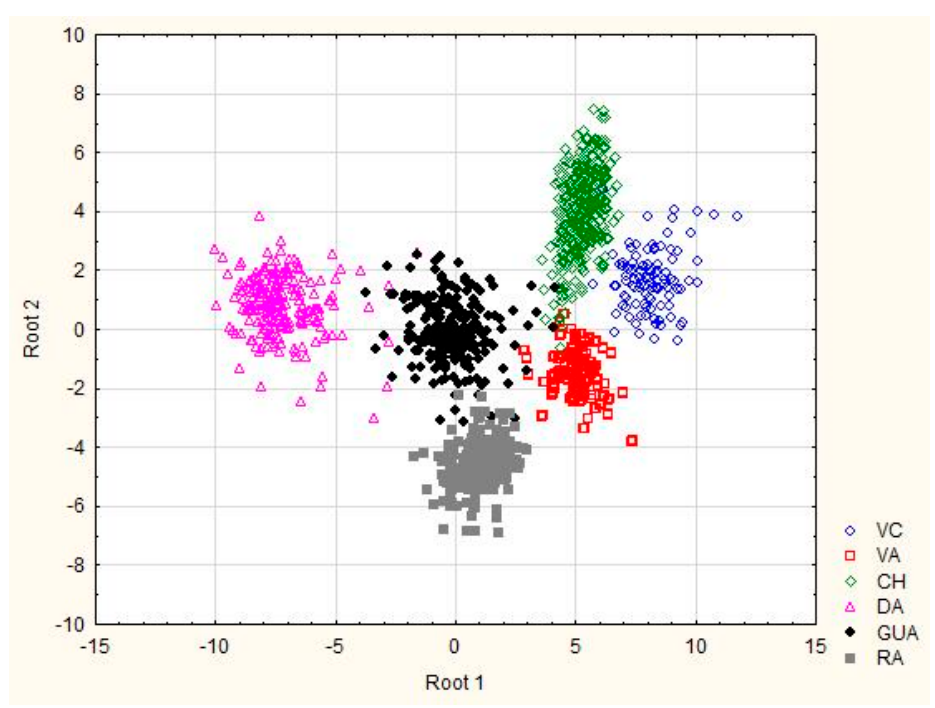
Figure 2. Cluster from Mahalanobis distances in six freshwater species from Ecuador. VC: Cichla- soma festae ; VA: Andinoacara rivulatus ; CH: Dormitator latifrons ; GUA: Hoplias microlepis ; RA: Lepo- rinus ecuadorensis ; DA: Brycon dentex .